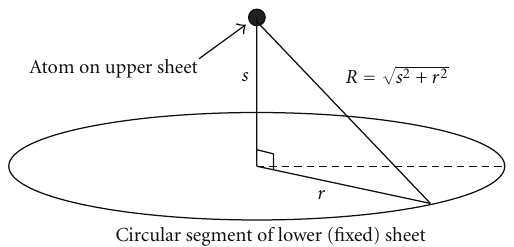
s Atom on upper sheet